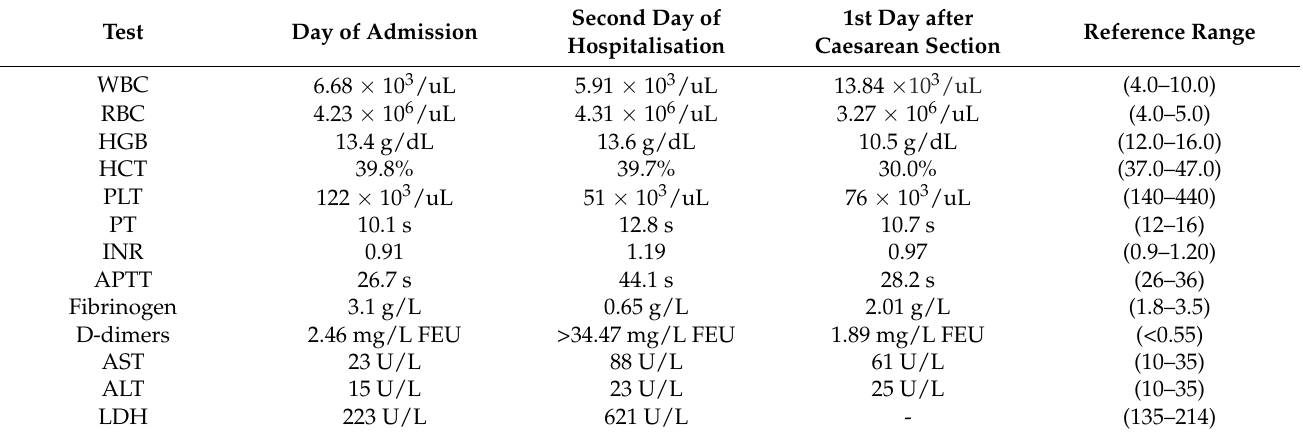
Table 3. Laboratory test results on the day of admission to hospital and second day of